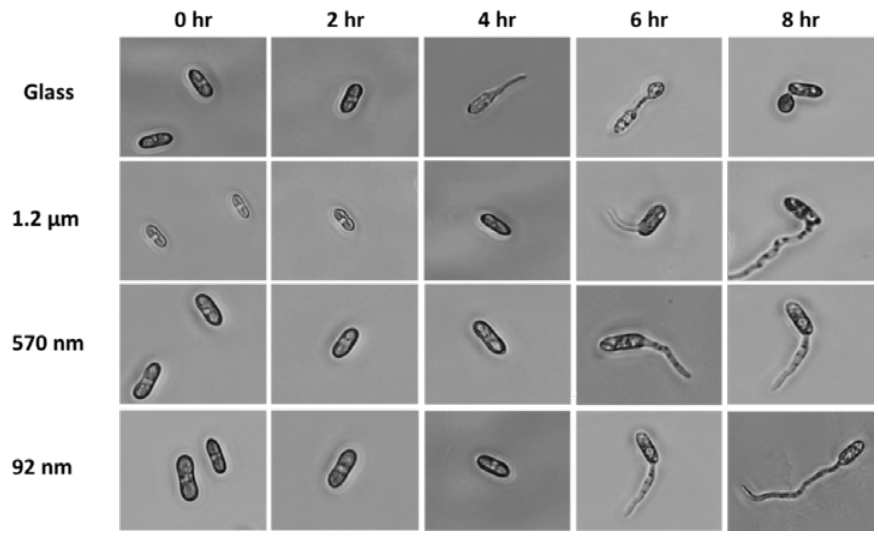
Figure 6. Formation of C. gloeosporioides for di ff erent Ag particle sizes and contact times.